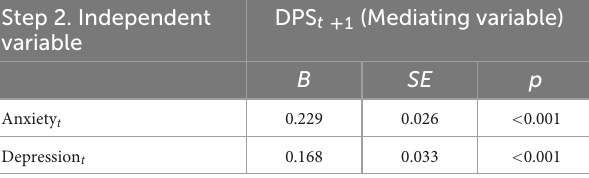
TABLE 3 Step 2 in mediating analysis of Anxiety t , DPS t + 1 , and Anxiety t + 2 and mediating analysis of Depression t , DPS t + 1 , and Depression t + 2 . Step 2. Independent